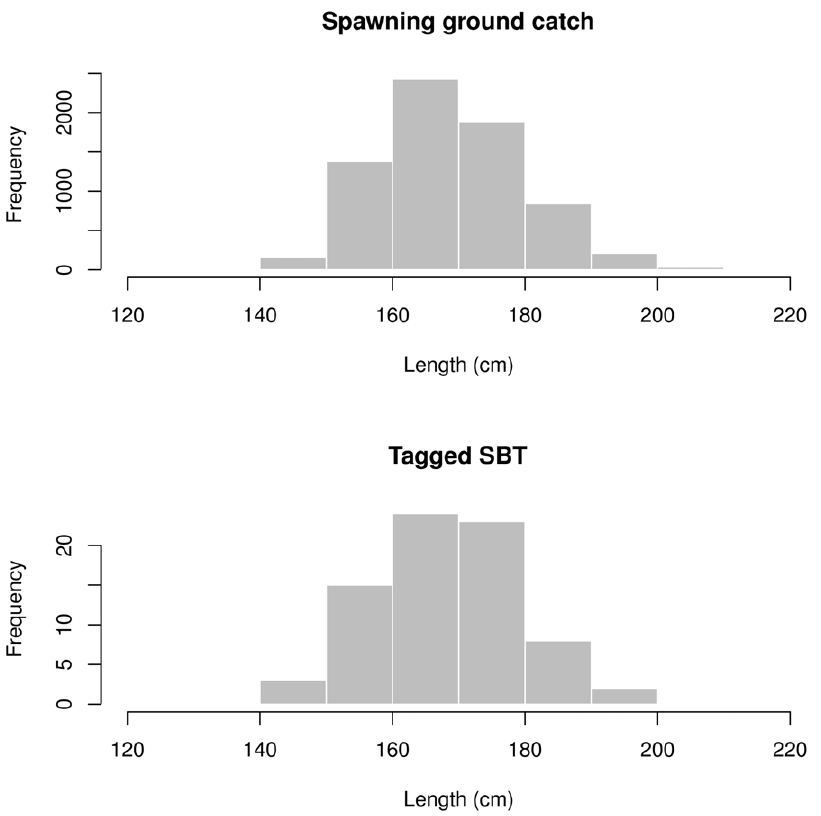
Figure 1. Length frequencies of SBT caught by the Indonesian fishery on the spawning ground and SBT tagged in this study.